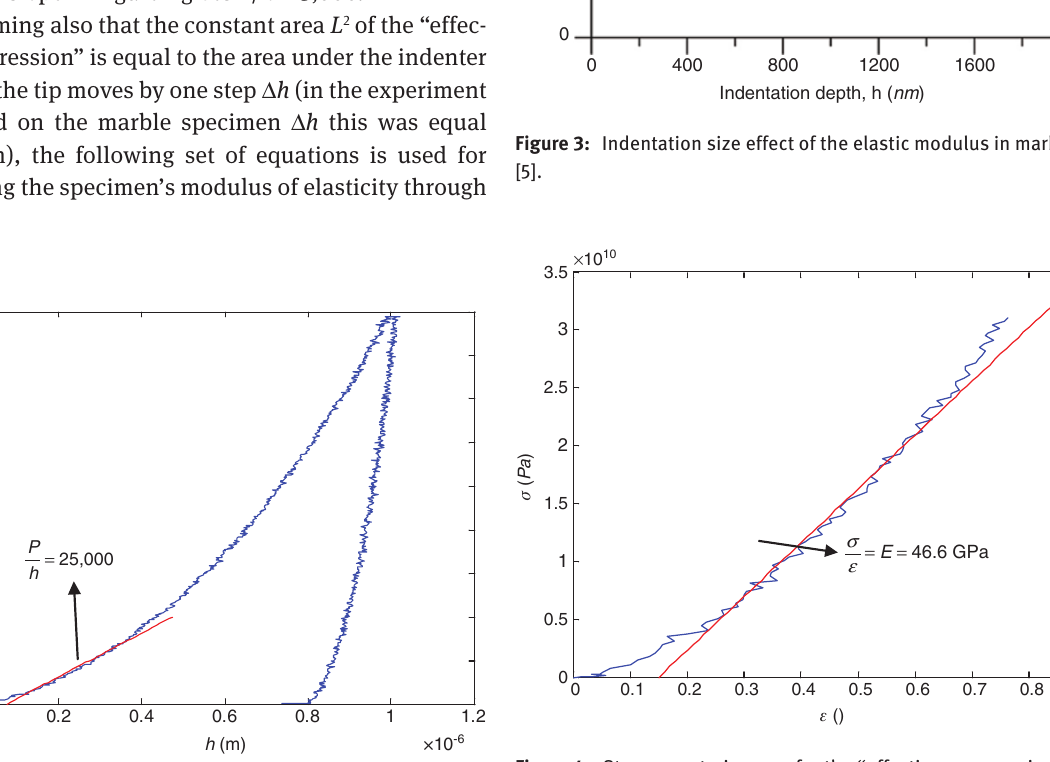
Figure 4: Stress vs. strain curve for the “effective compression” using Eqs. (10)–(13) for the marble specimen. The slope of the red line which gives the modulus of elasticity is 46.6